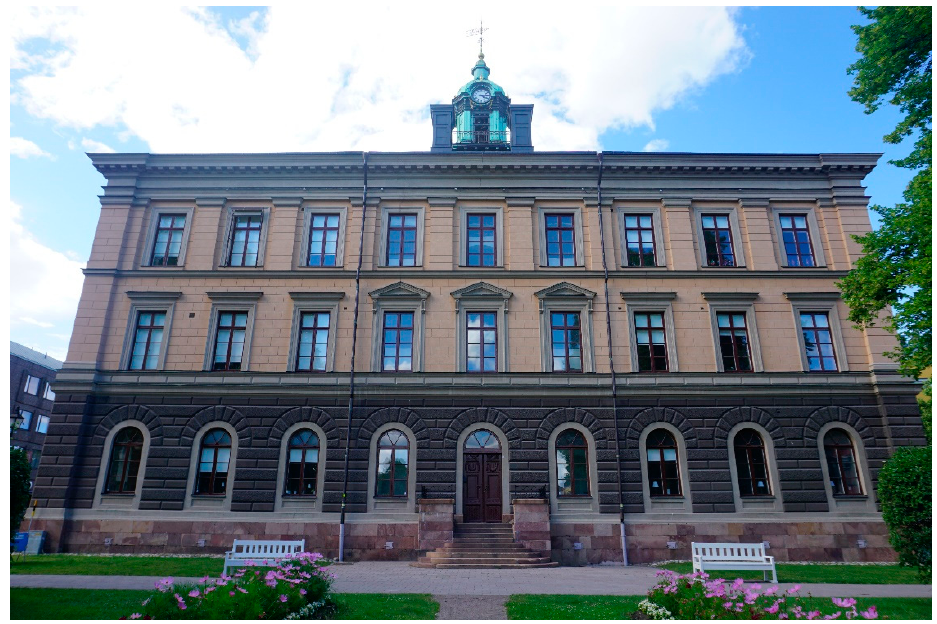
Figure 1. The building of the City Hall of Gävle (photo: Abolfazl Hayati) .